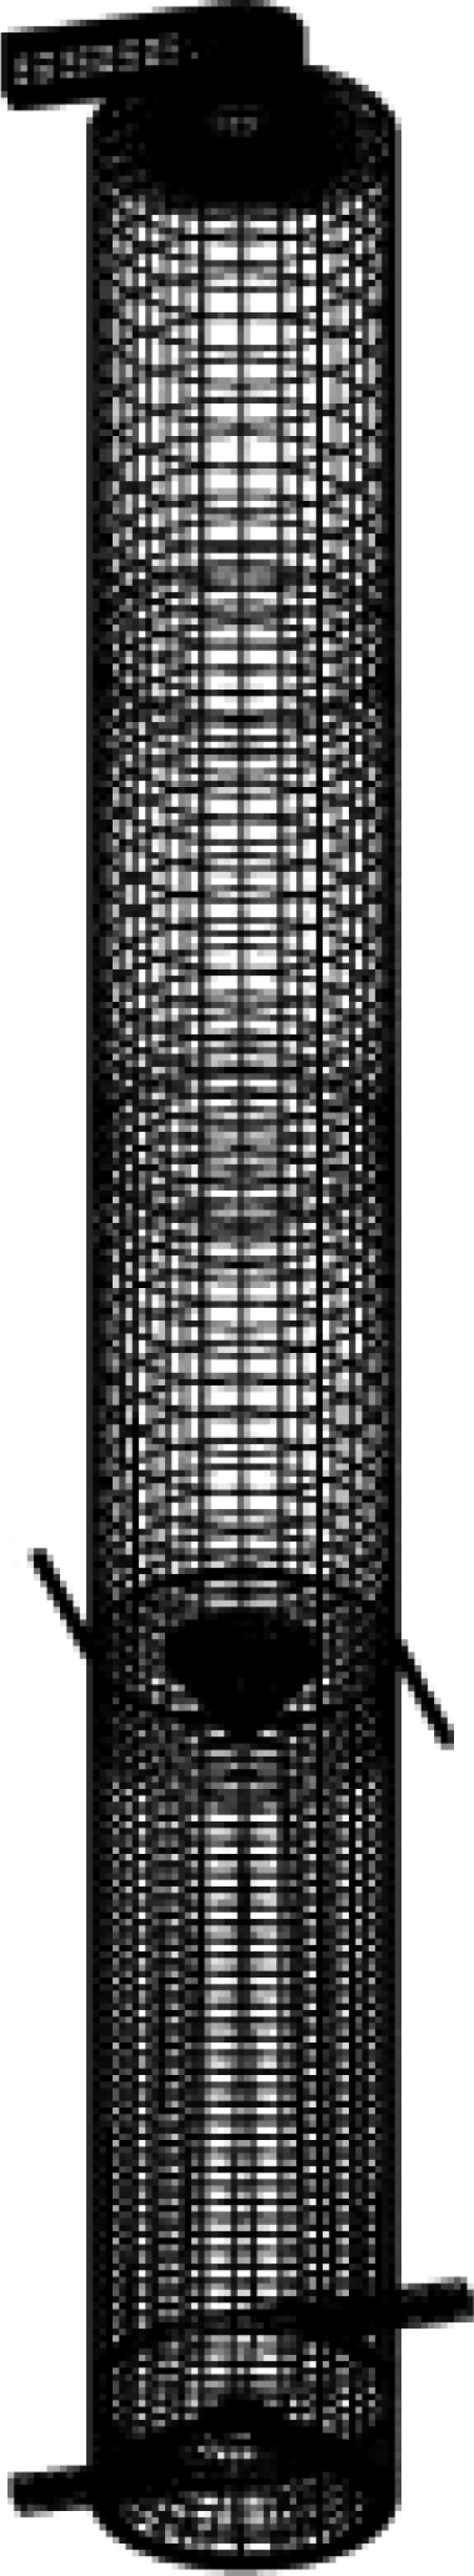
The geometry of the gasifier. The lower inlets are used to inject the biomass mixed with air, and the upper inlets are used to inject steam [15].